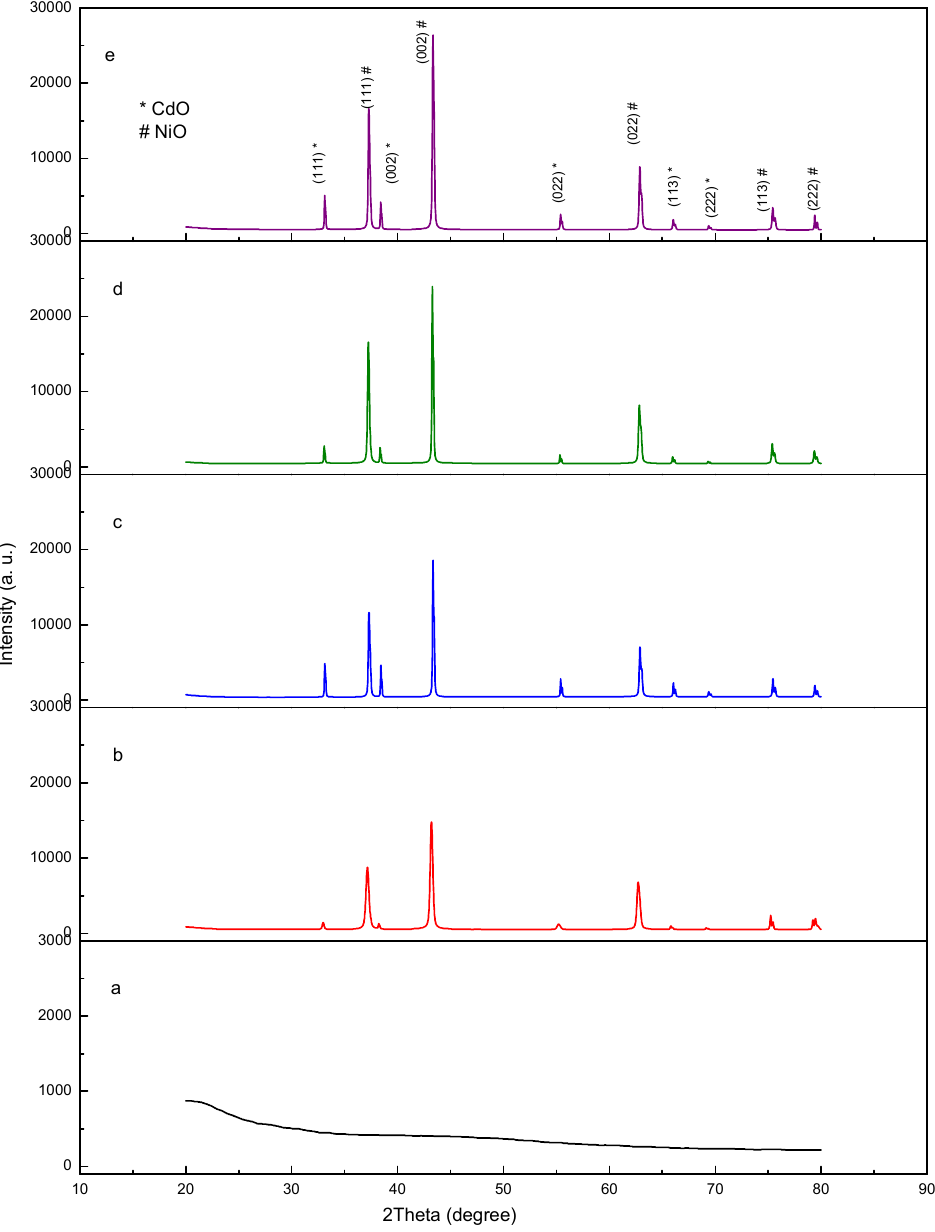
Figure 3. XRD results of the prepared samples in calcinations of ( a ) room temperature, ( b ) 500, ( c ) 600, ( d ) 700, and ( e ) 800 °C. Table 1. XRD results of the prepared sample were calculated using diffraction peak by Scherrer formula at temperatures of 800 °C.